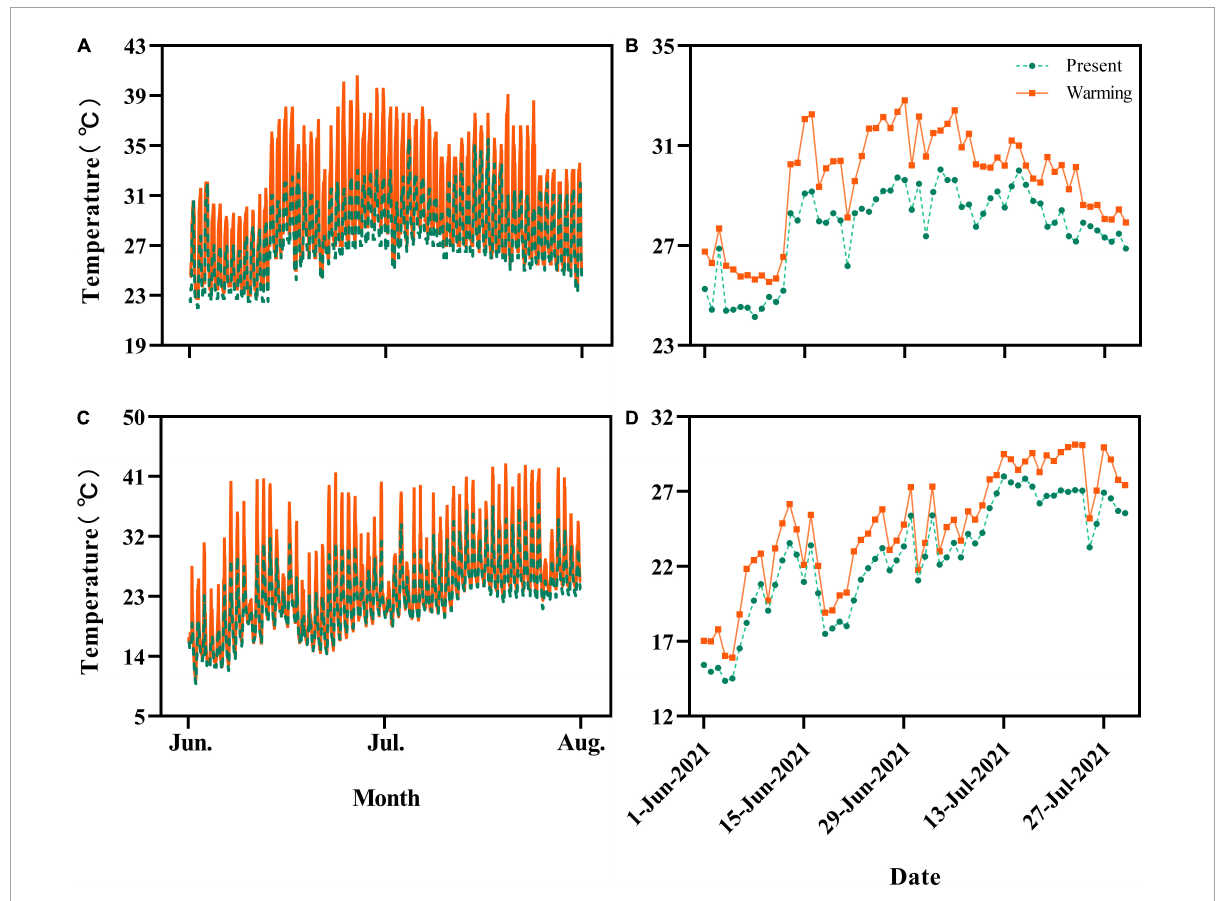
FIGURE1 Hourly and daily average temperatures experienced by Eremias argus (A,B) and Takydromus amurensis (C,D) in the semi-natural enclosures, respectively. Green and orange lines indicate the temperatures of the present climate and warming climate conditions,